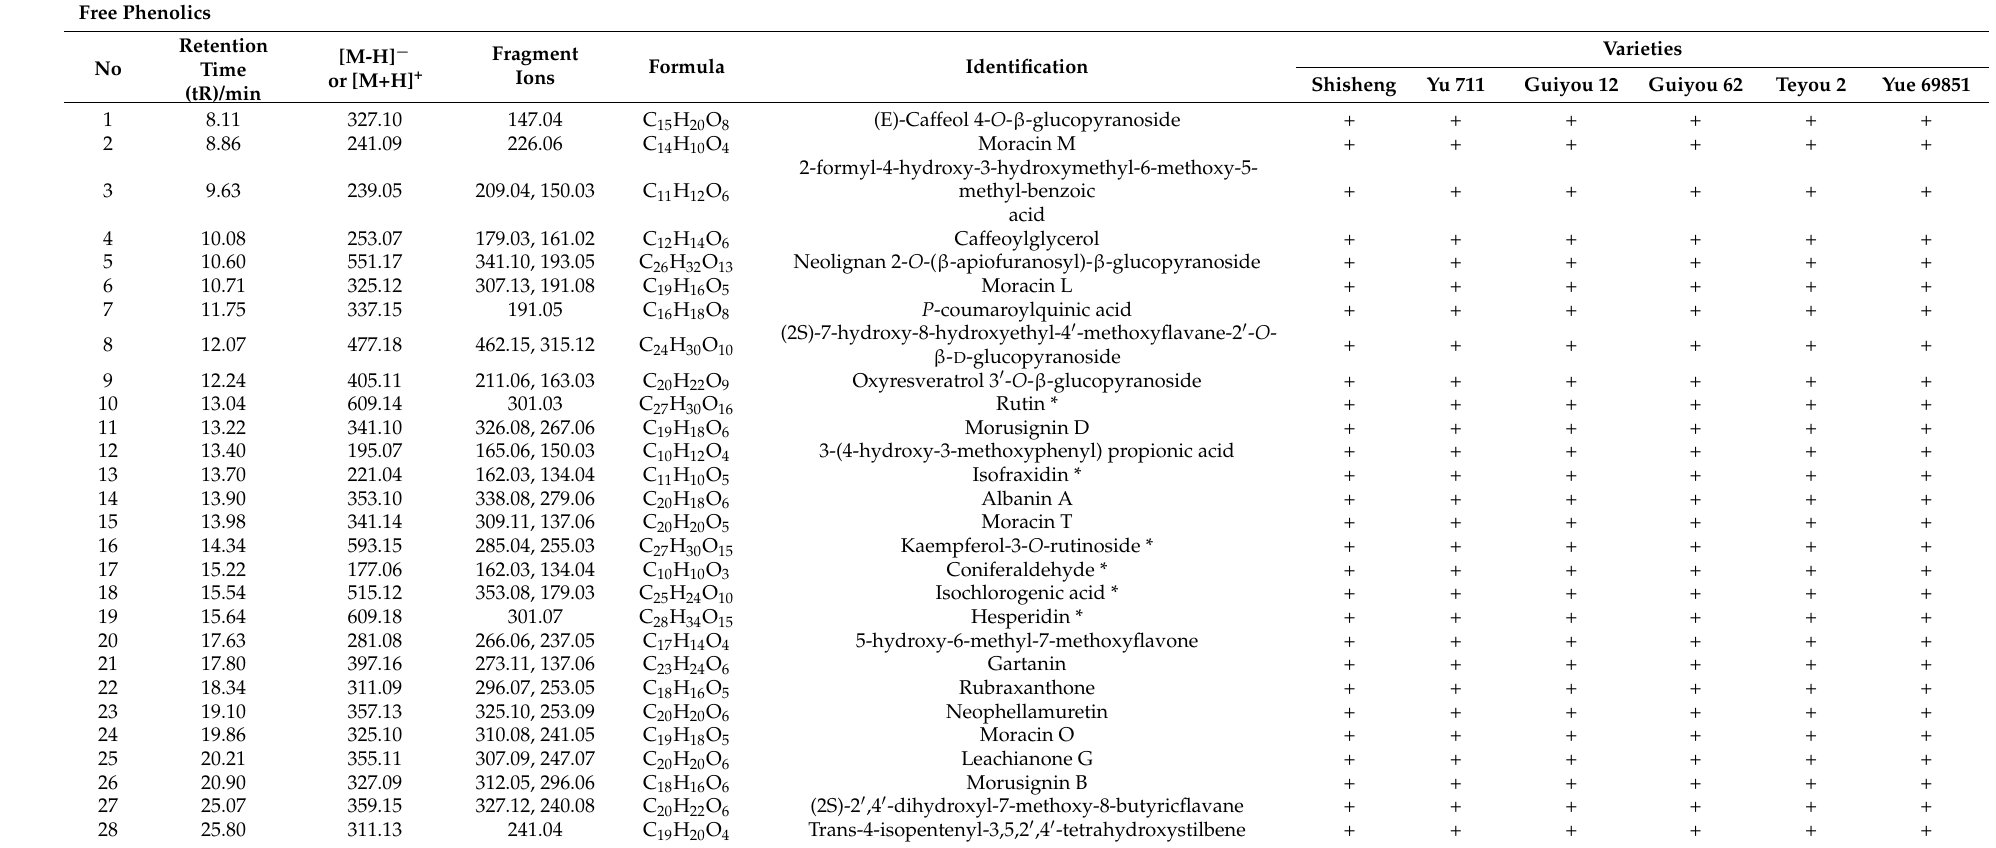
Table 1. Identification of FPs and BPs in mulberry